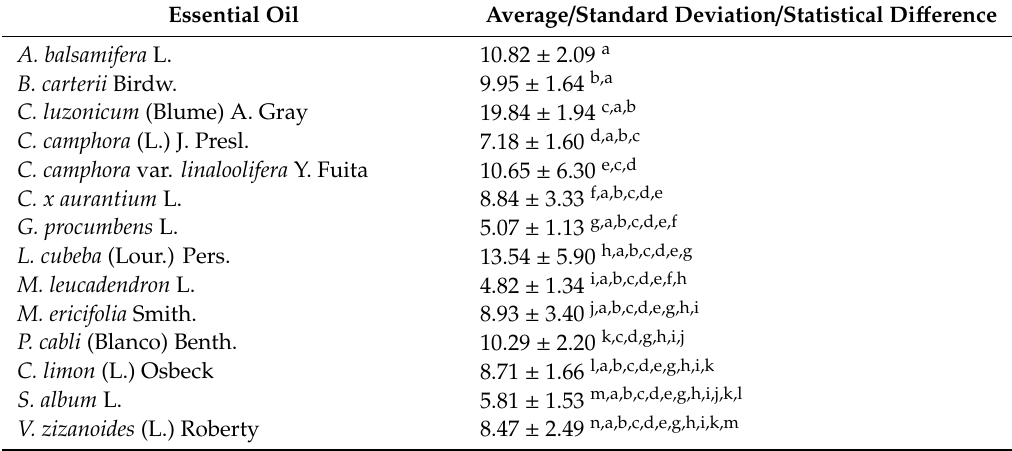
Table 7. Di ff erences between the analysed essential oils in their activity against Staphylococcus spp. Essential Oil